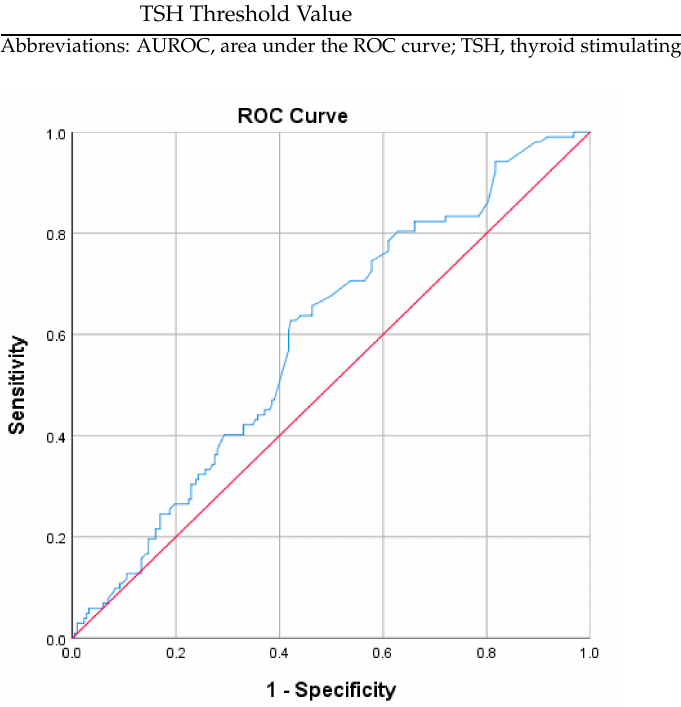
Figure 2. Receiver operating characteristic (ROC) curve for thyroid-stimulating hormone